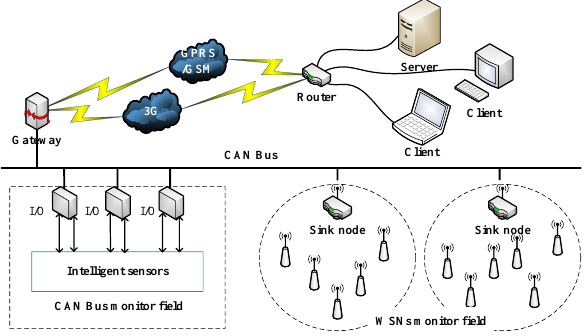
Figure 9. Online monitoring system architecture.